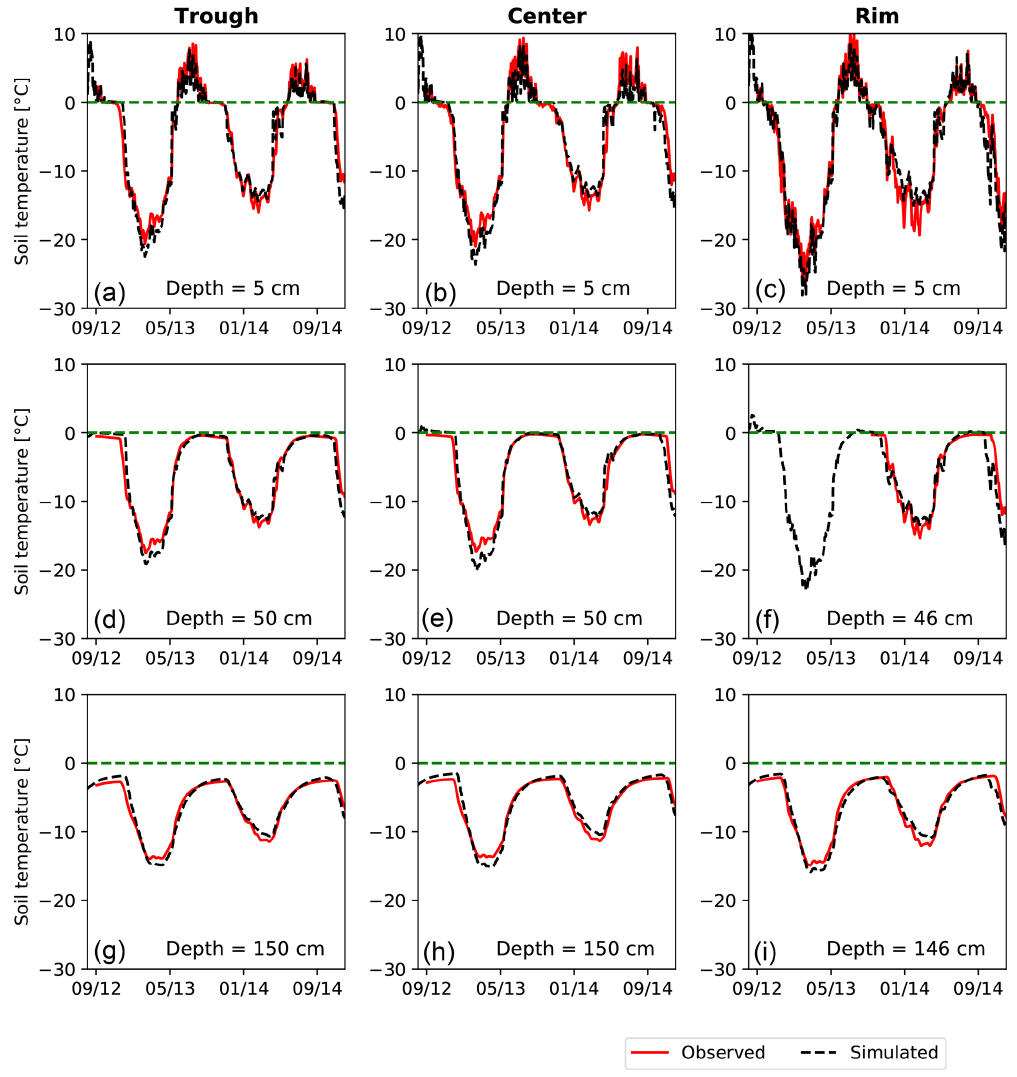
Figure 4. Comparison of simulated and observed soil temperatures in the (a, d, g) trough, (b, e, h) center, and (c, f, i) rim for the years 2012–2014 at several depths. Rows correspond to the depth from the ground surface and display measured and simulated soil temperatures (a, b, c) in the organic matter layer, (d, e, f) near the depth of the active layer, and (g, h, i) in the 150cm deep